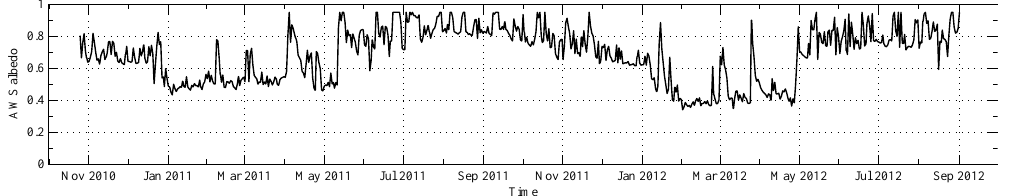
Figure 3. Daily accumulated albedo record (i.e. the ratio of accumulated SW ↑ and SW ↓ over a day) of Brewster Glacier, 25 October 2010 to 1 September 2012 (Cullen and Conway, 2015). Note that an upper threshold of 0.95 was applied when SW ↓ was compromised by snow covering the upper radiation sensors during heavy snowfall (35 occurrences out of 678